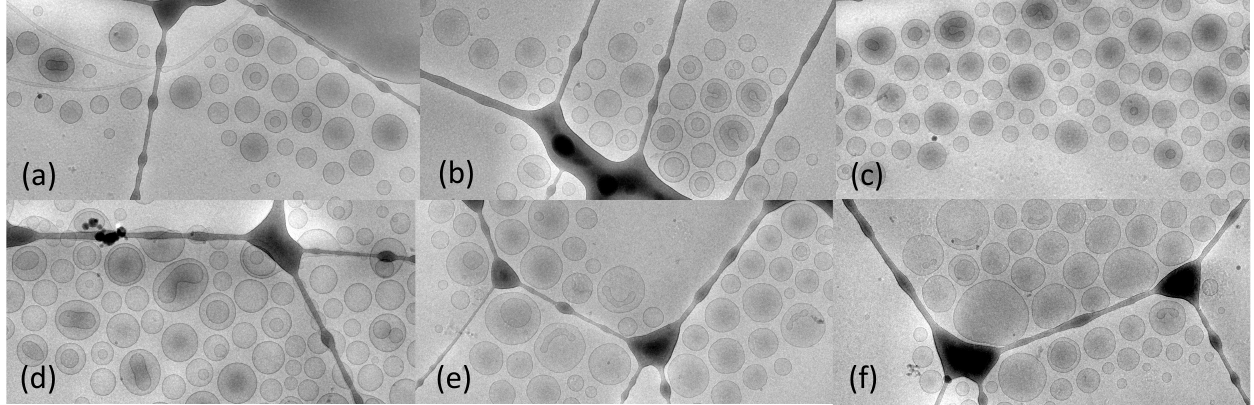
Figure 4. Cryo-TEM images of the produced liposomes visualized after extrusion: LS-MP ( a ), LS- MDE2 ( b ), LS-MDB ( c ), LN-MP ( d ), LN-MDE2 ( e ), and LN-MDB ( f ). Bar corresponds to 500 nm.